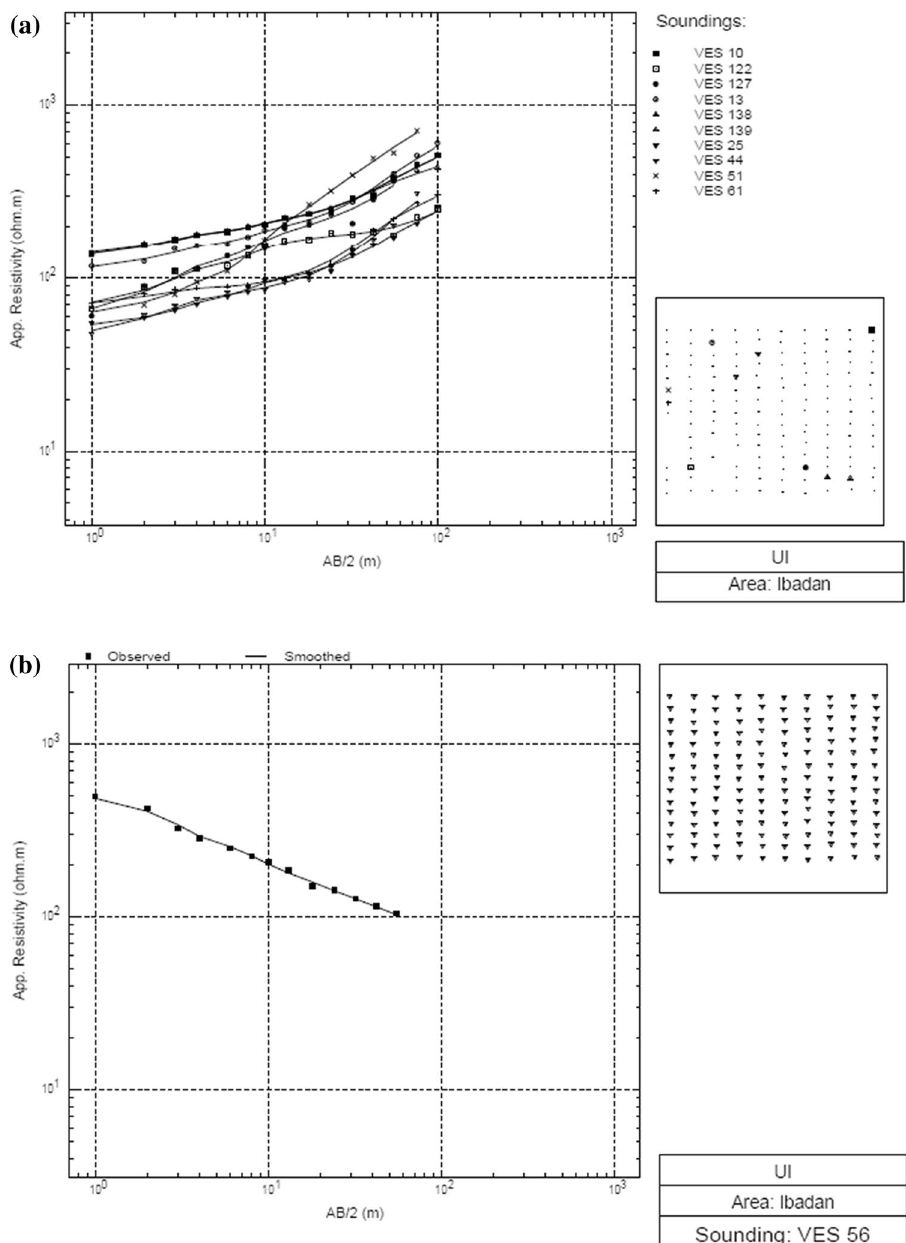
Fig. 9 Representative a A, b